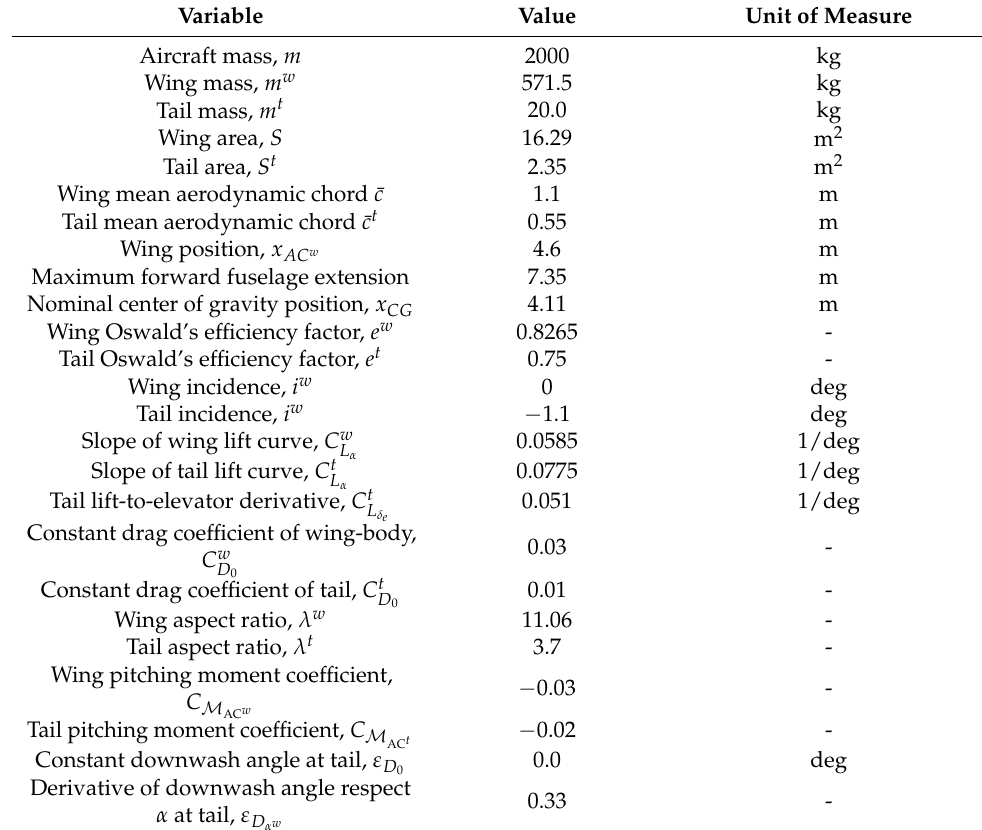
Table 1. Main characteristics of the nominal aircraft model, loosely based on the Diamond DA42 Twin Star. Longitudinal axis is pointing forward and has origin in the aerodynamic center of the tail. Variable Value Unit of